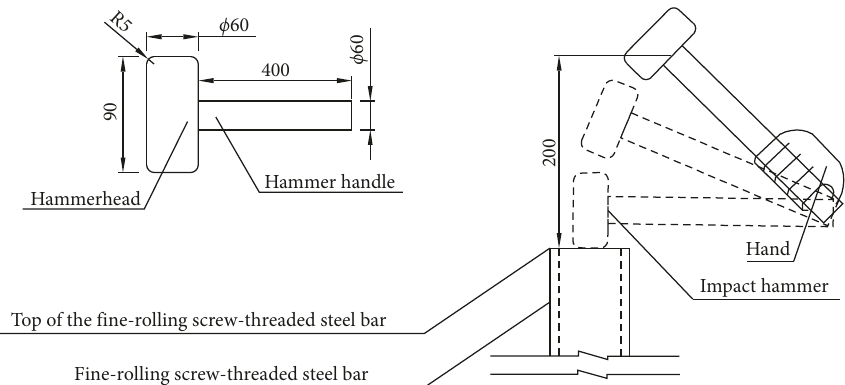
Figure 8: Diagrams showing (a) the impact hammer and (b) shock excitation.